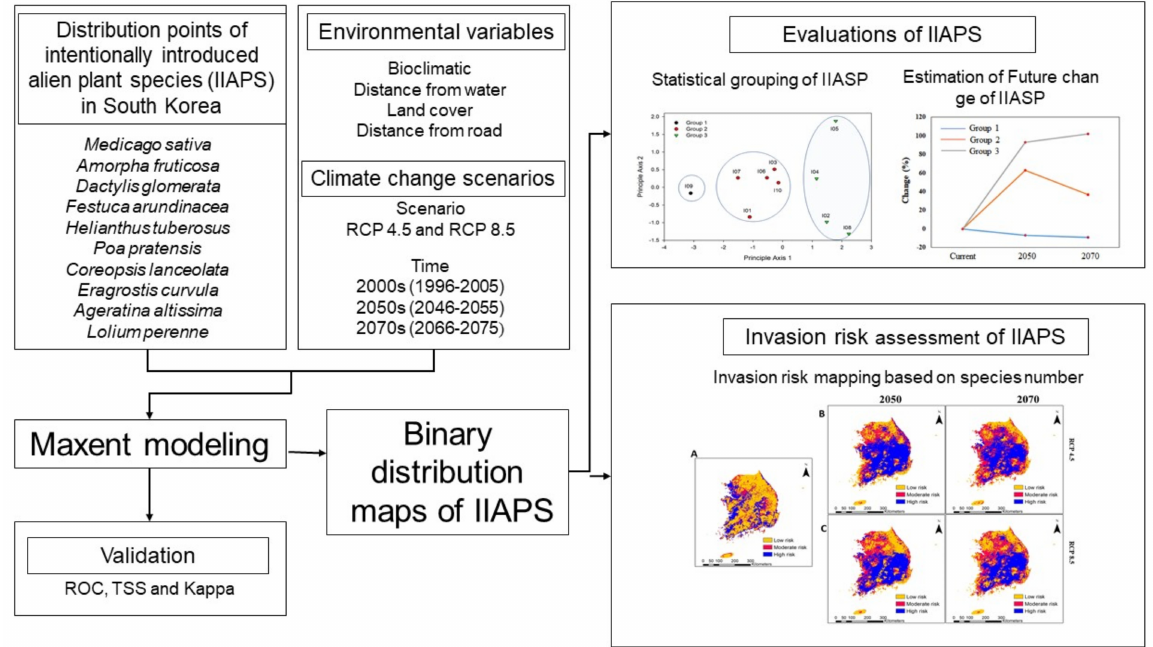
Figure 3. Flow—chart of the development and building blocks of the MaxEnt model and its practical application in estimating the invasion risk of intentionally introduced alien plant species in South